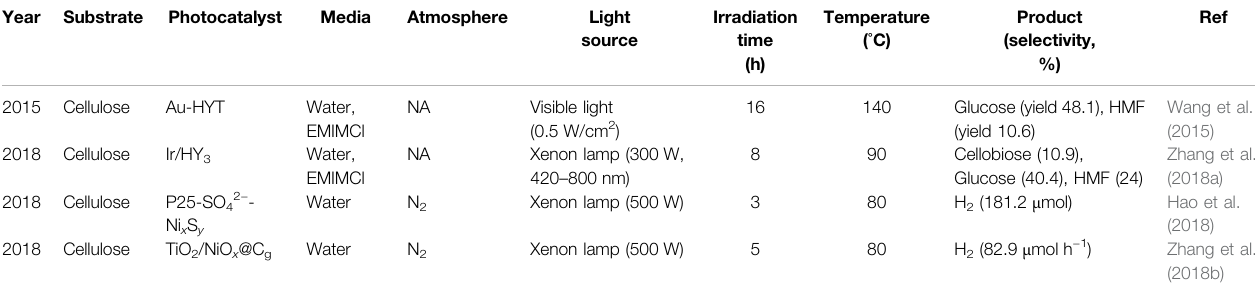
TABLE 1 | Photocatalytic conversion of cellulose in the literature.